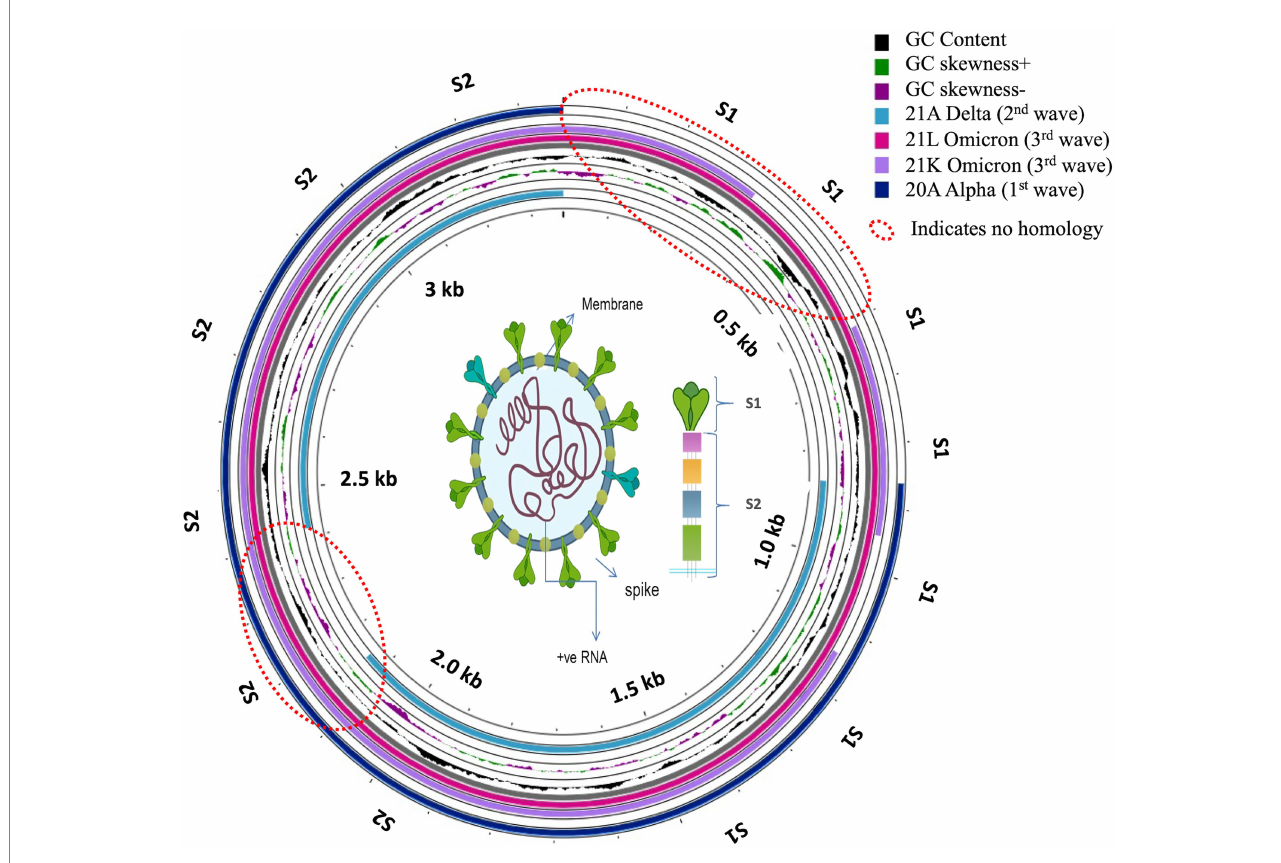
FIGURE 8 Circular presentation of neighborhood homology mapping of consensus Spike proteins for the first, second and third waves of